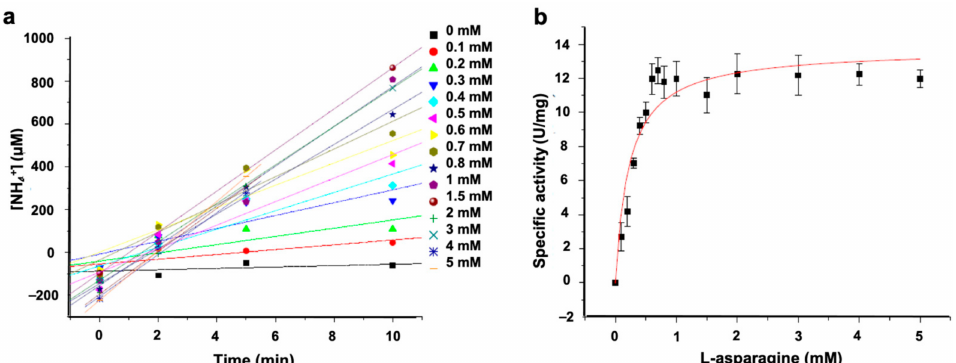
Figure 3. Kinetic parameters of ASNase-P22 nanoreactors based on the Michalis-Menten’s model. ( a ) Initial rates (V0) calculated for different concentration of Asn are indicated on the right. At 5 mM of substrate, the enzyme is saturated. Color codes of the substrate concentration are shown. ( b ) Specific activity fit to the Michaelis-Menten’s model. Chi 2 = 1.68. R 2 = 0.84. ( n = 3). Error bars represent the standard